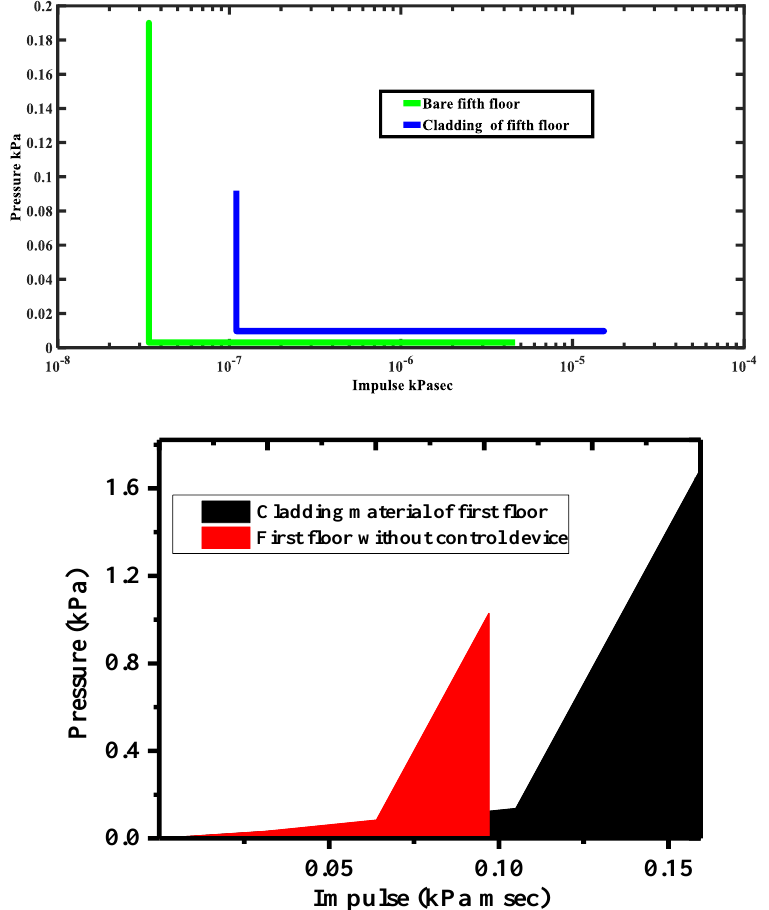
Fig. 12. Pressure impulse curve of 10 storey structure by cladding